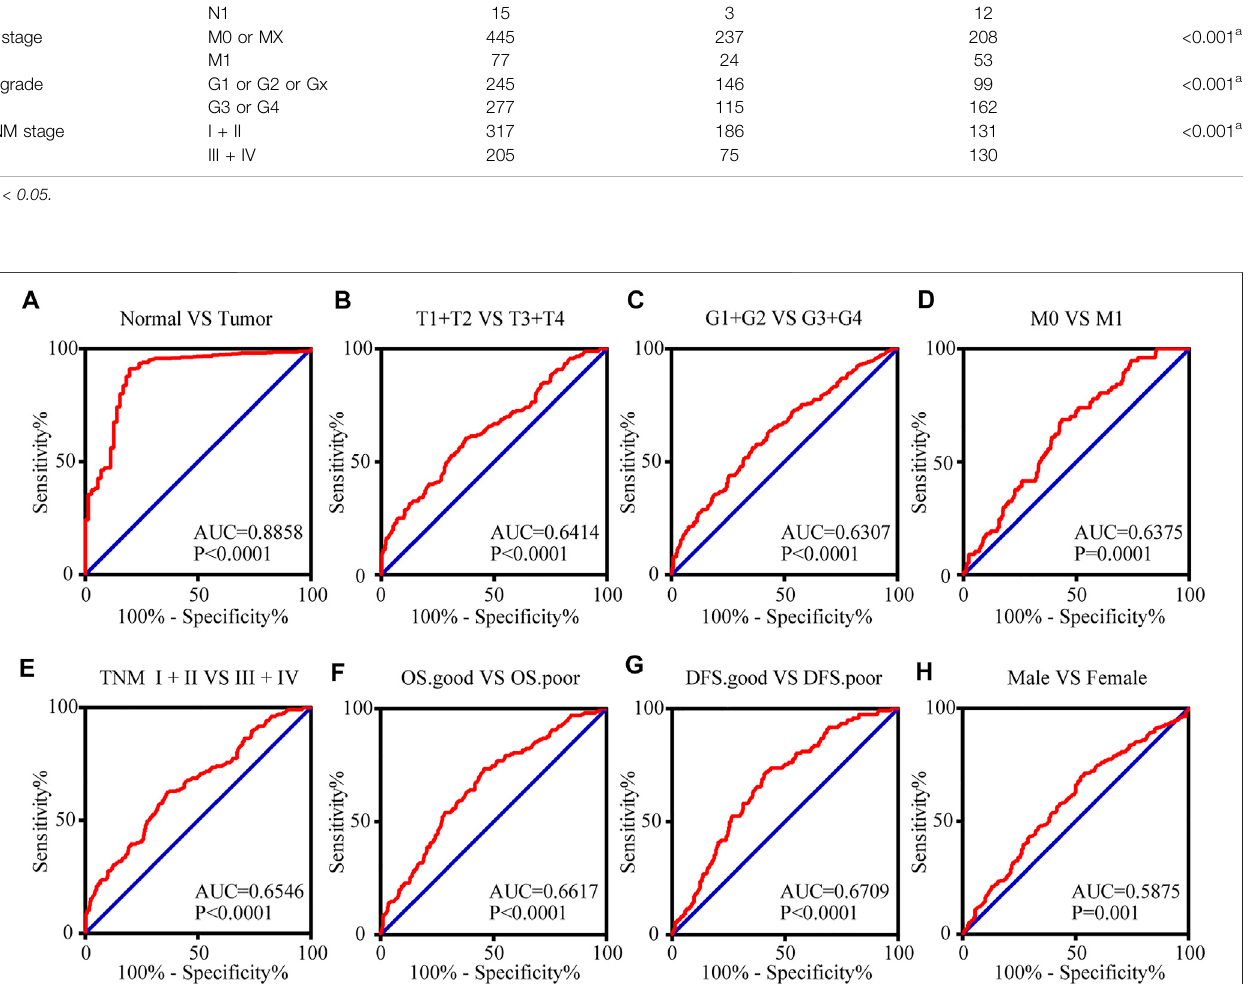
Frontiers in Genetics |